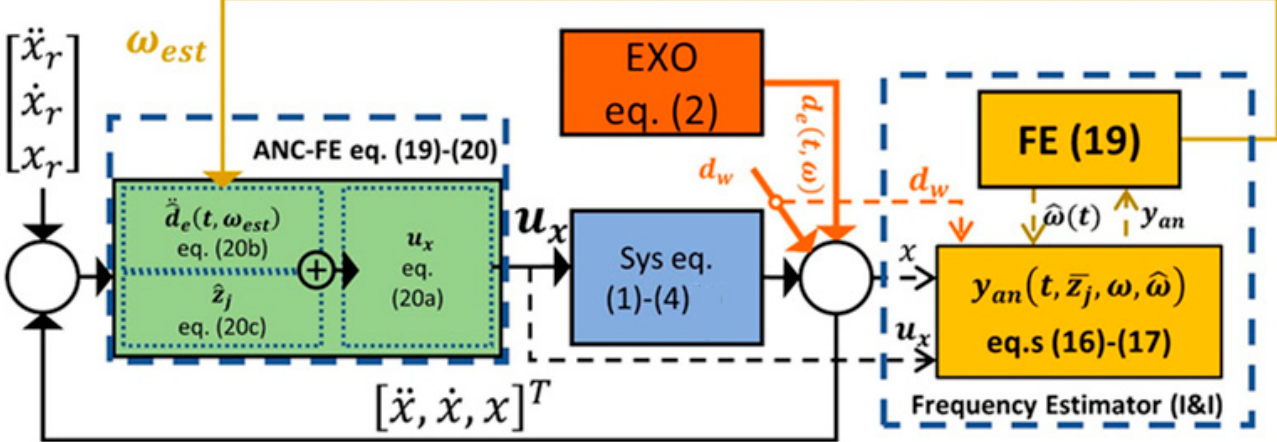
Figure 2. ANC-FE (adaptive noise cancellation with frequency estimation) [1].